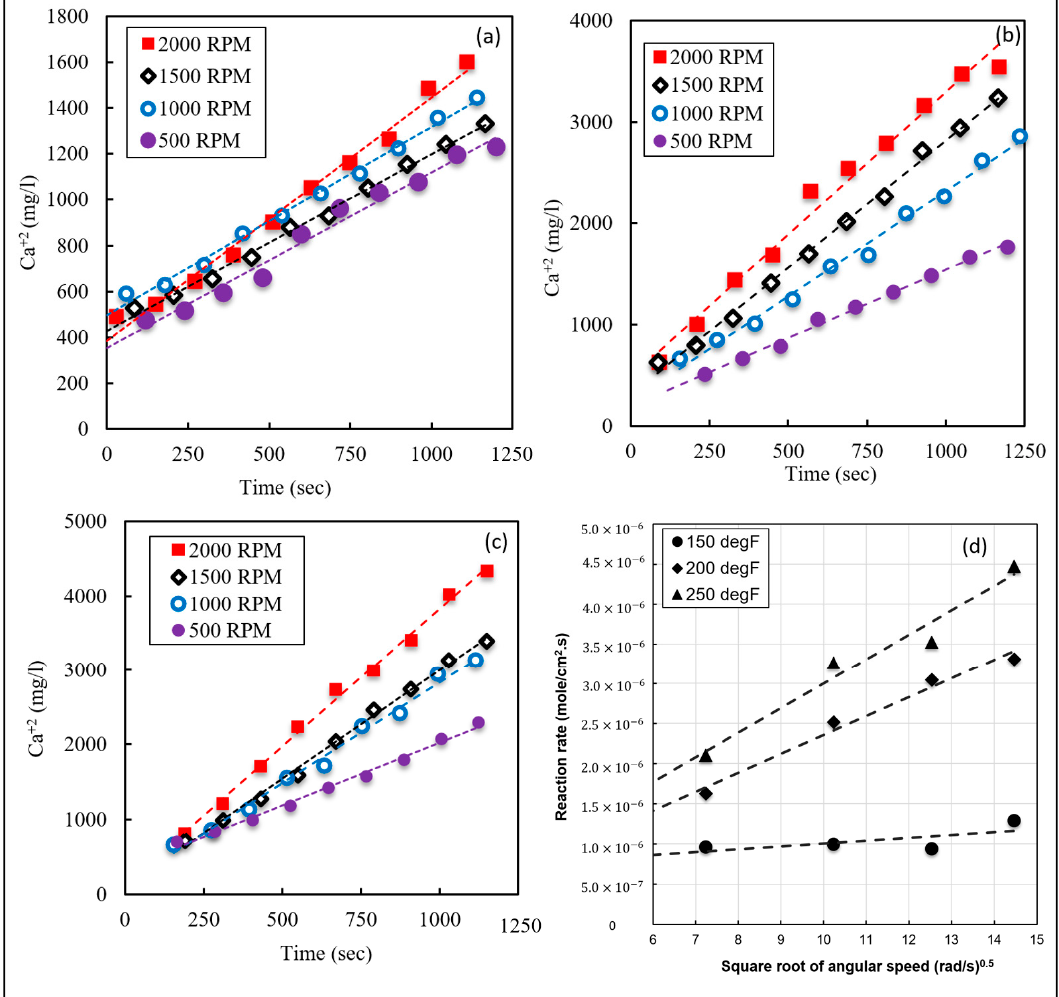
Figure 7. The concentration of calcium in the collected fluid samples as a function of time and rotation speed using 20 wt% GLDA/SW solution at 150 °F ( a ), 200 °F ( b ), and 250 °F ( c ), and the rate of calcite dissolution by 20 wt% GLDA/SW (pH 3.8) at corresponding temperatures ( d ).